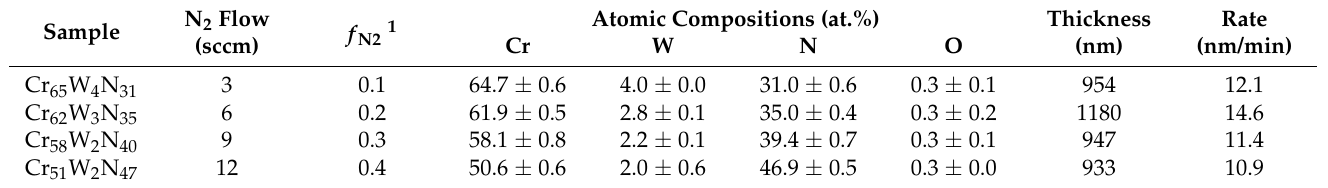
Table 1. Co-sputtering parameters, atomic compositions, and thicknesses of CrWN coatings.